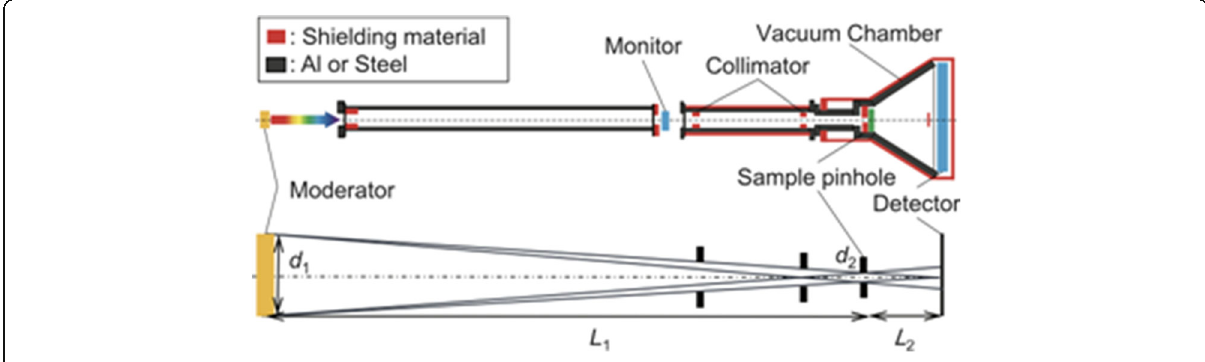
Fig. 6 Layout of an intermediate-angle scattering instrument, iANS at HUNS